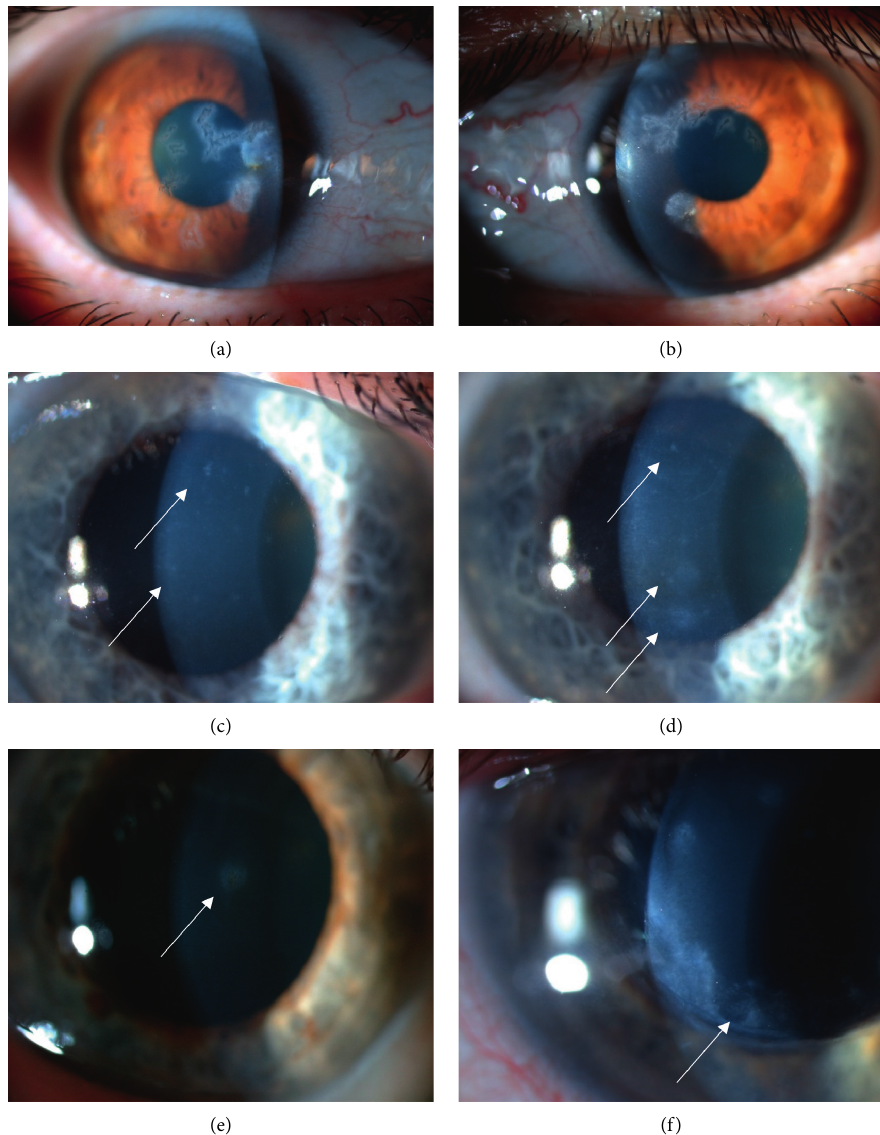
Figure 1: Corneal opacities in six eyes of four patients with monoclonal gammopathy. Sharp-edged, branching predescemetal opacities in both eyes of one patient with monoclonal gammopathy of ocular significance (MGOS) (a, b), sharpe-edged, round or puntual, fine subepithelial opacities in both eyes of one subject with cornea guttata and multiple myeloma (c, d), round stromal opacity in one eye of one subject with multiple myeloma (e), sand-like stromal deposits along the removed penetrating keratoplasty (PKP) running-suture line in one eye of one subject with multiple myeloma